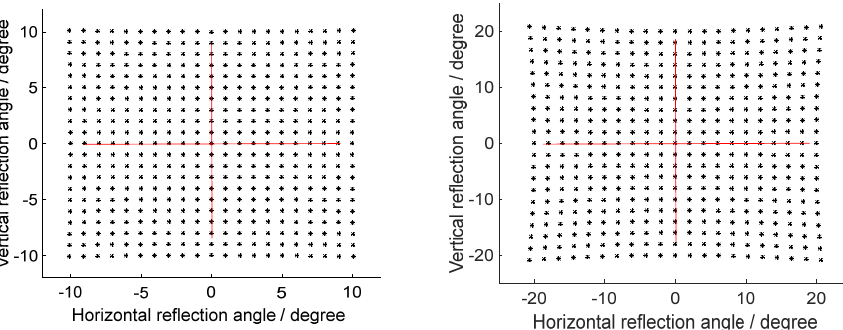
Figure 4. The variation of the deflection angle of the outgoing light with the deflection angle of the MEMS micromirror in both horizontal and vertical directions (the deflection angle of the left figure is ±5 ° ; the deflection angle of the right figure is ±10 ° ).